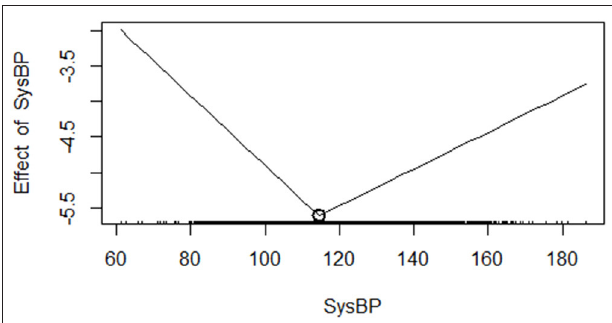
FIGURE 4 | Identification of the trajectory cutoff